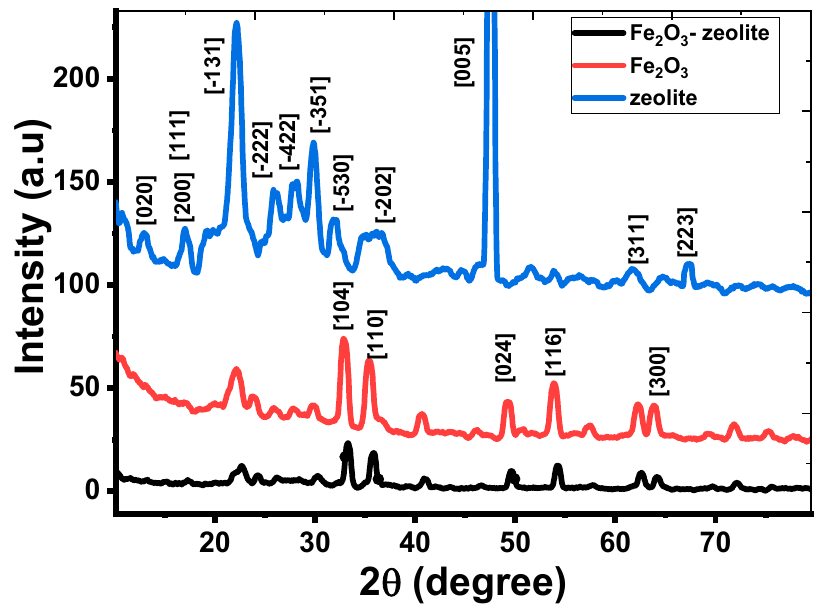
Figure 2. XRD patterns of zeolite, Fe 2 O 3 , and Fe 2 O 3 -zeolite photocatalysts.